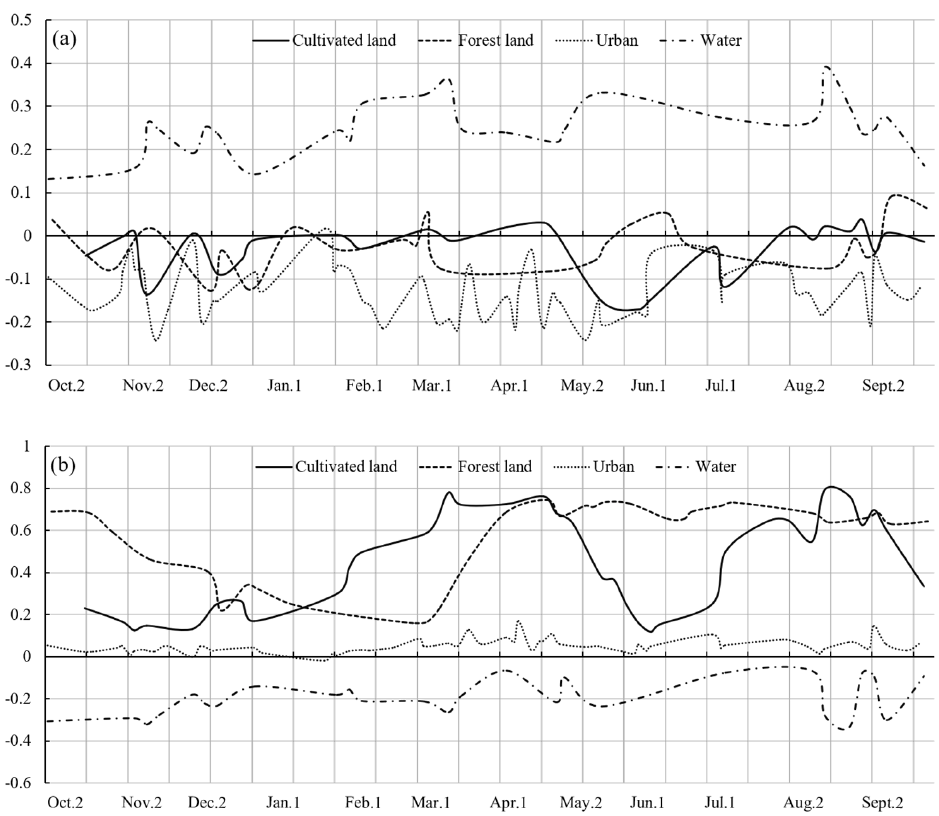
Figure 5. The vegetation index time series for the four landcover types. ( a ) NDWI; ( b ) NDVI. Table 3. Dynamic thresholds of forestland/cultivated land and image acquisition date for crop extraction. We randomly generated 1000 sample points in the cultivated land mask data, and verified the accuracy of cultivated land classification based on the high–resolution image Image Acquisition Date for of Google Earth. The result shows that there are 972 cultivated land sample points and 28 Area Ratio of Different Terrain Regions (%) NDVI-Based Threshold Crop City between Forest Land non–cultivated land sample points (most of which are intercropping under forest and gar- and Cultivated Land den land). The accuracy of cultivated land extraction is 97.2%, which can meet the require- ments of the crop extraction.